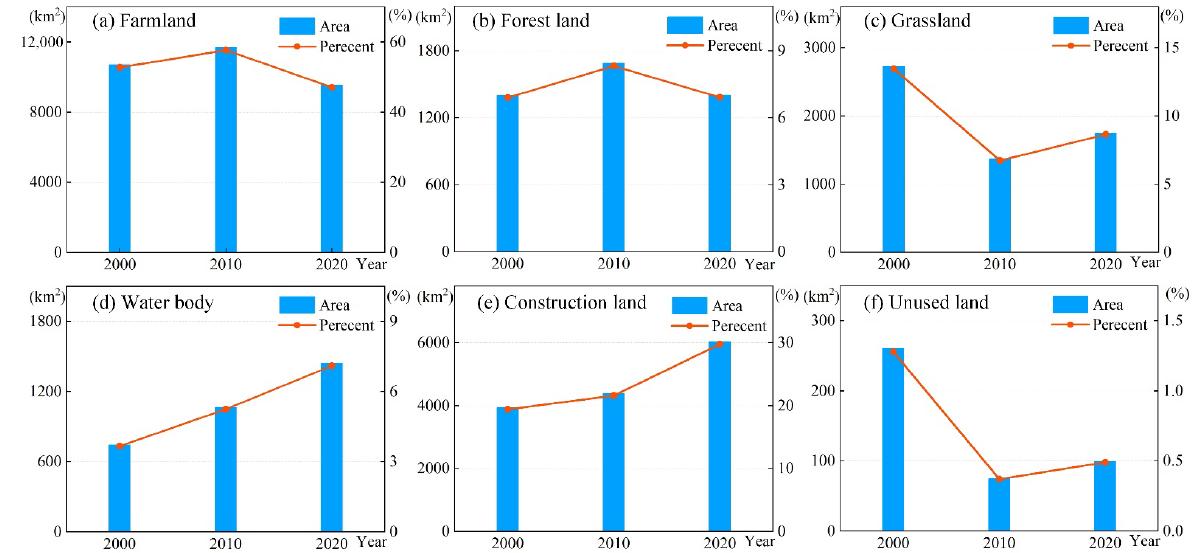
Figure 6. Area changes of each land use/land cover type, ( a ) Framland, ( b ) Forest land, ( c ) Grassland, ( d ) Water body, ( e ) Construction land, ( f ) Unused land.